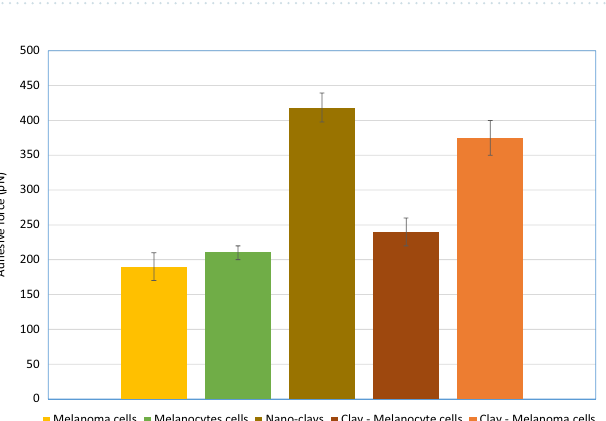
Figure 4. Melanoma tissue histology images of H&E staining. Some representative tumour images were photographed. Each insertion of magnified areas in the top right corner, highlighting some important figures. Arrows point to the areas of insertion. ( A , B ) Untreated (control) tumours demonstrated multiple cells undergoing mitosis, with no inflammation or necrosis. The magnified insertion of ( A ) shows cells with condensed chromatin, most likely in the prophase of mitosis. The magnified portion of ( B ) shows multiple cells with condensed chromatin, and two cells recently underwent mitosis. ( C , D ) Tumours treated one time during the initial treatment demonstrated cells undergoing mitosis, with some inflammatory cell infiltration. The magnified insertions of both ( C , D ) show cells with condensed chromatin. ( E , F ) Tumours treated weekly for 4 weeks demonstrated very few cells undergoing mitosis. The magnified insertion portion of ( E ) shows white cell infiltration around necrotic tissue, while the magnified insertion of ( F ) highlights necrotic tissue. ( G , H ) Tumours treated twice a week for 4 weeks showed significant white cell infiltration and some necrosis. In the magnified portion of ( G ), some necrotic tissue with cellular infiltrate is present, while the magnified portion of ( H ) shows cellular infiltration. ( I , J ) Tumours treated daily showed significant necrosis and white cell infiltration. The infiltration around blood vessels can be seen in the magnified portion of ( I ), while the infiltration in necrotic tissue is highlighted in ( J) .